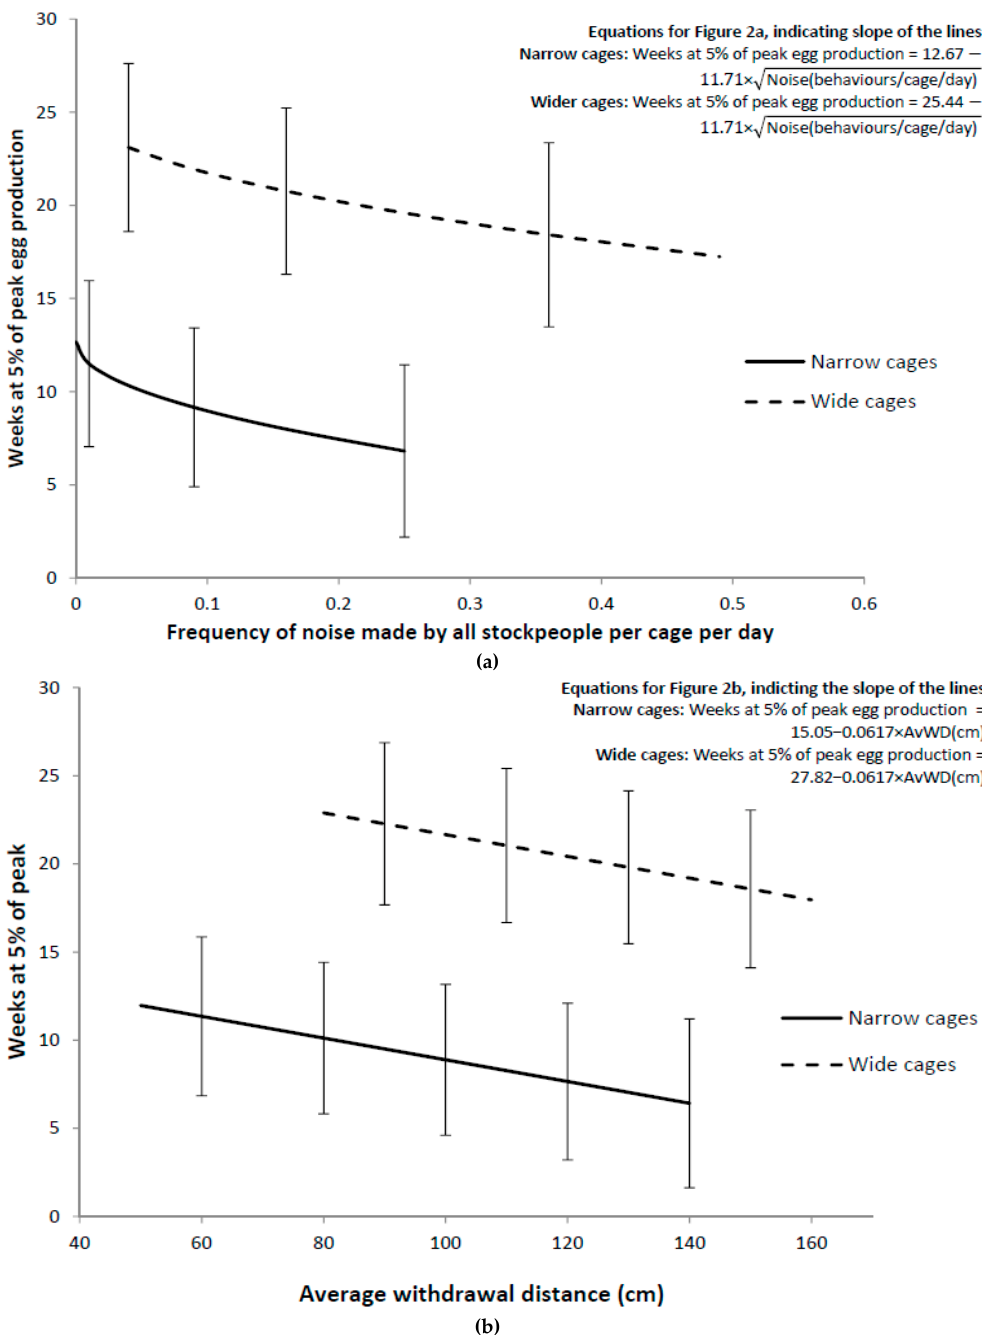
Figure 2. ( a ) Relationship between weeks at 5% of peak egg production and all stockperson noise, after adjusting for average withdrawal distance (AvWD), for the two cage width groupings. The noise responses, for each grouping, are presented at the between shed mean of average withdrawal distance, for sheds in that grouping. ( b ) Relationship between weeks at 5% of peak egg production and AvWD, after adjusting for the square root of all stockperson noise, for the two cage width groupings. The AvWD responses, for each grouping, are presented at the between shed mean for all stockperson noise, for sheds in that grouping. Error bars are 95% confidence intervals using the asymptotic normal approximation.